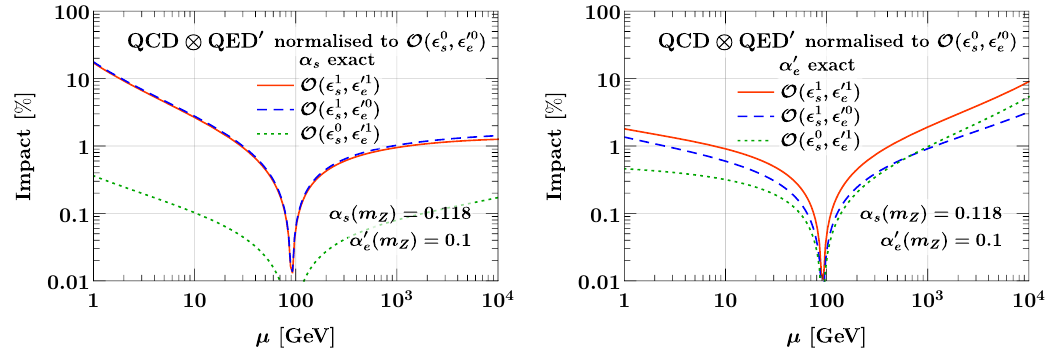
Figure 4 . Same as (cid:12)gure 3 but for QCD (cid:10) QED 0 , where QED 0 is a toy theory with a modi(cid:12)ed boundary condition of (cid:11) 0 ( m Z ) = 0 : e